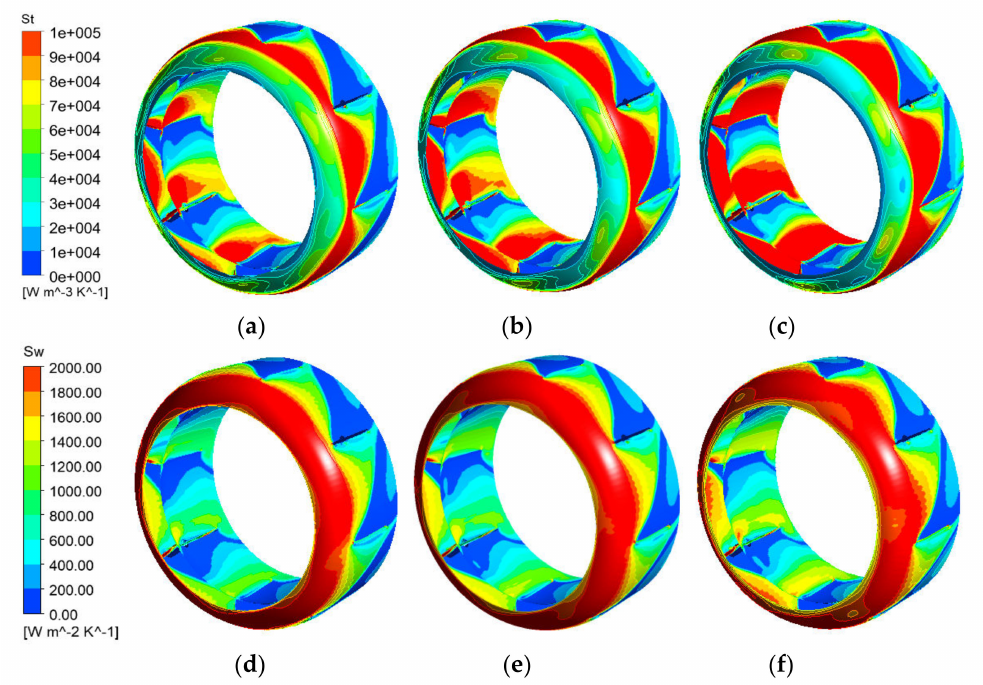
Figure 6. Entropy generation distribution of the guide vane. Turbulent kinetic energy